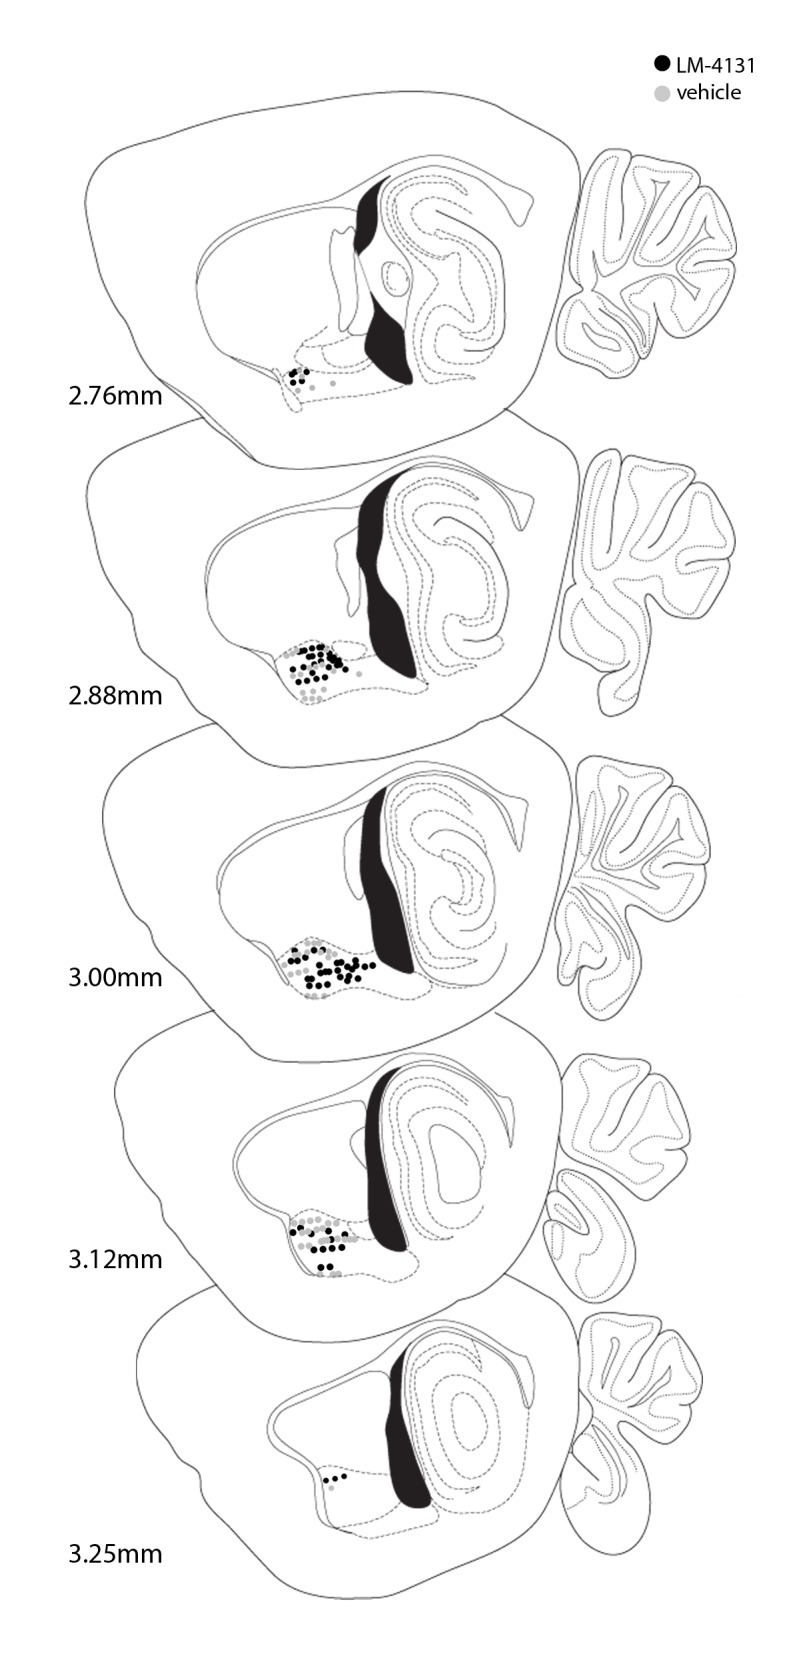
Schematic diagram of in vivo electrophysiological recording sites.Black dots represent cannula tip locations for vehicle and grey dots represent cannula tip locations for LM-4131 treated mice. Numbers refer to coordinates lateral to bregma for each sagittal brain section.